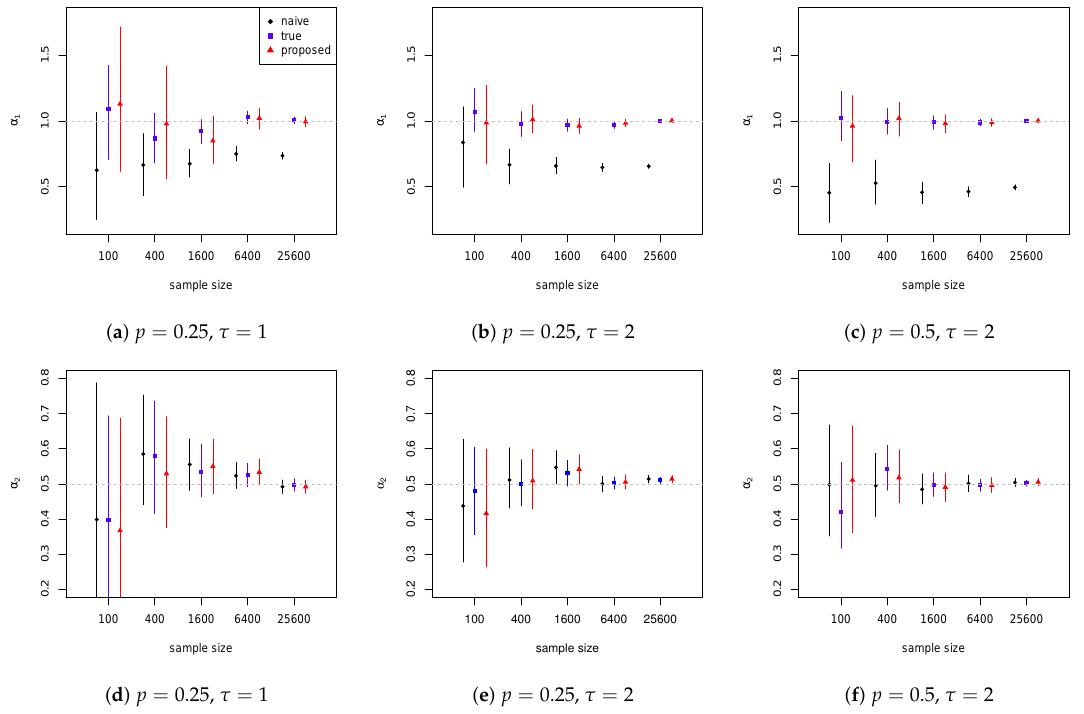
Figure 1. Credible intervals for the risk effects of V (top) and X (bottom) for the Weibull loss severity model. The dashed line marks the true